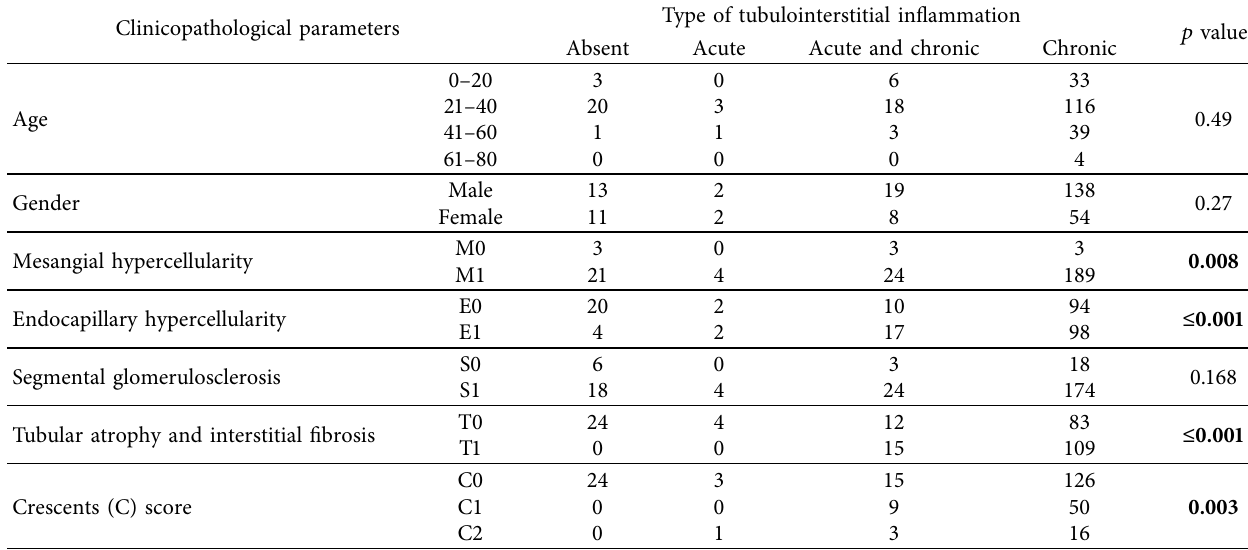
Table 4: Relationship between MEST-C score and type of tubulointerstitial infammation. Clinicopathological parameters